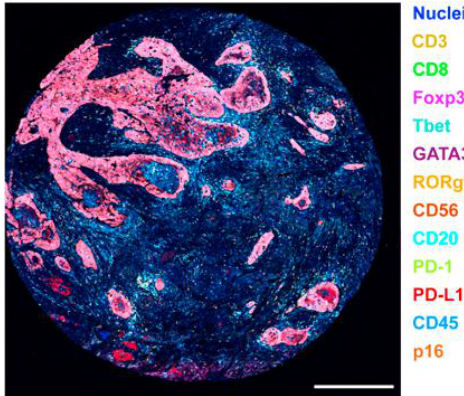
Figure 2. HNSCC FFPE sections stained with lymphoid biomarkers. Biomarkers and colors are shown on the right. Scale bar, 500 µm.(Reprinted with permission from [24] . Copyright 2017 Elsevier).